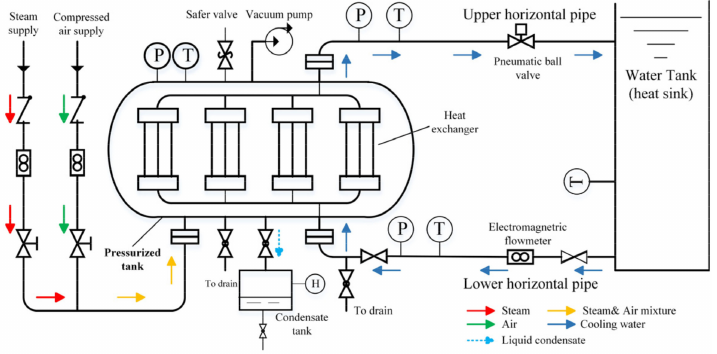
Figure 1. Schematic of the experimental